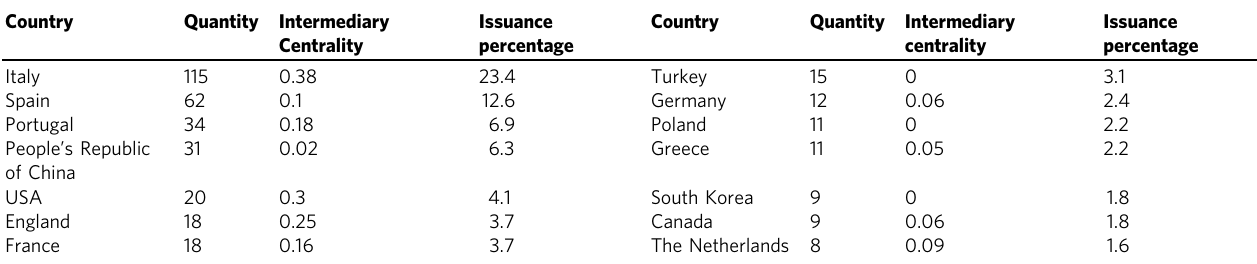
Table 2 Geographical distribution of HBIM studies.